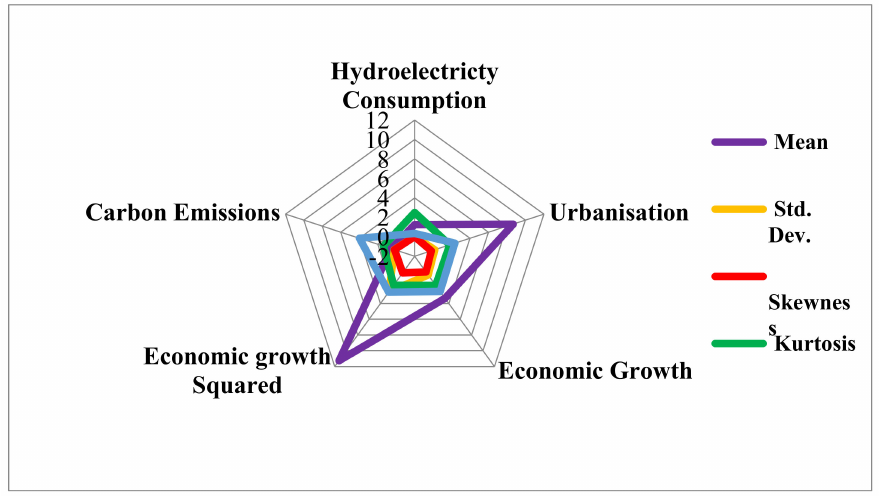
Figure 1. Descriptive